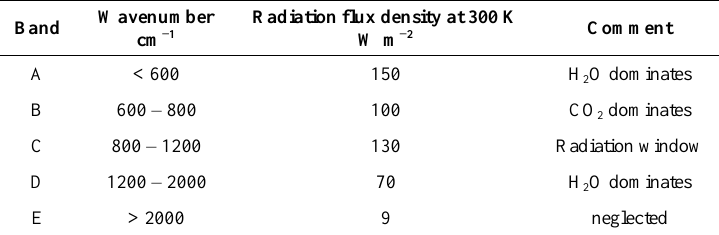
Figure 5. Infrared absorption spectra of water vapour (H 2 O, black curve). The corresponding spectrum of carbon dioxide (CO 2 , blue curve) is drawn with a downward offset of log 10 (33) = 1.5 units of the ordinate, so that it corresponds graphically to H 2 O with a mass ratio of 33:1 of the tropical marine atmosphere at 300 K and 80 %rh as well as 400 ppm CO 2 . Original data were taken from the article of Zhong & Haigh (2013) [196]. For the logarithmic scale of the ordinate, a doubling of the CO 2 content would move its (blue) curve upward by log 10 (2) = 0.3 units, as indicated by the short arrow “2 x CO 2 ”. Thermal radiation at 300 K has its maximum at k ≈ 650 cm −1 , near the boundary between the bands A and B (red). The properties of the bands A – E are described in Table 1. Table 1. Infrared spectral absorption properties (simplified) of H 2 O und CO 2 with a mass ratio of 33:1, which corresponds to a tropical marine atmosphere at 300 K and 80 %rh as well as 400 ppm CO 2 , as shown in Figure 5. The radiation flux density of the particular bands A-E results from integrating Planck’s radiation law [197] between the related band limits